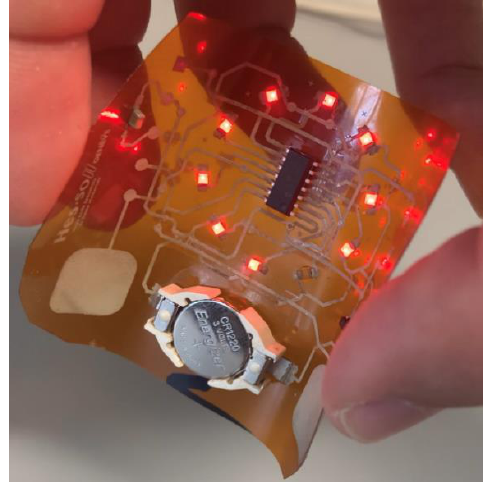
Figure 9. Photographic views of the demonstrator in operation. It was pad-printed on 127 µm thick flexible Kapton with three superimposed layers: first silver-based conductive layer, second UV insulating layer, and third silver-based conductive layer. The electronic circuit of the demonstrator controls the LEDs lighting by manipulating a two-key capacitive touch sensor.